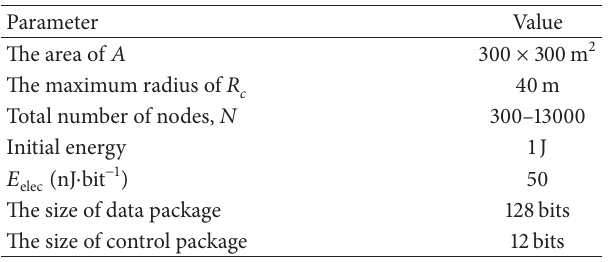
Table 2: Settings of simulation parameter.